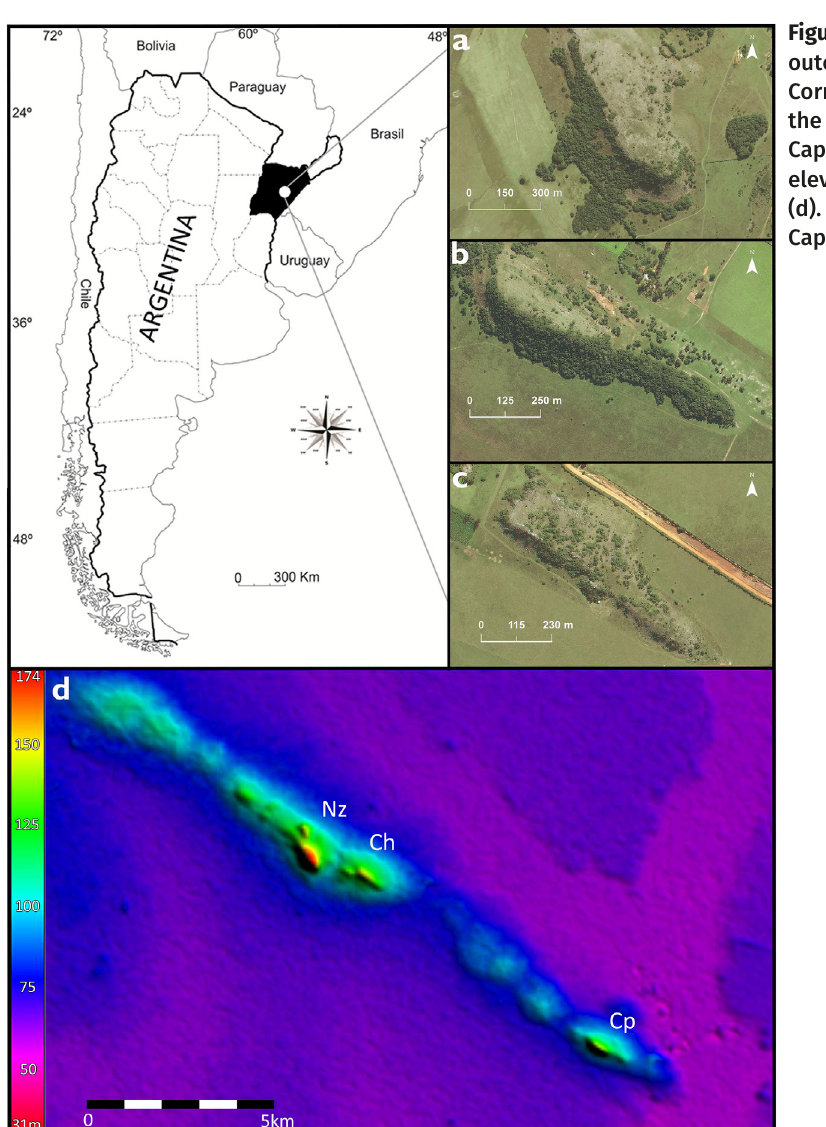
Figure 1. Isolated rocky outcrops of Paraje Tres Cerros, Corrientes, Argentina. View of the three hills Nazareno (a), Capará (b), Chico (c), Digital elevation model (SRTM image) (d). Nz: Nazareno; Ch: Chico; Cp: